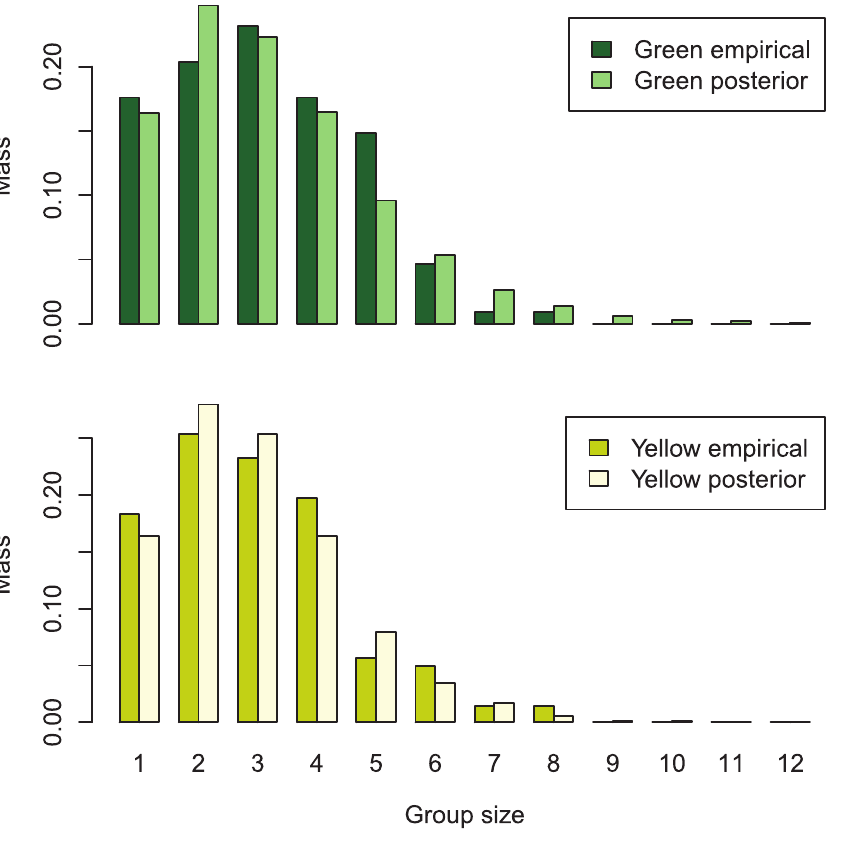
Figure 4. Empirical and posterior predictive distributions of golf tee group size. Bar plots representing the probability mass for group size in the golf tee experiment. Empirical distributions correspond to the actual distribution of group size used in the experiment, while posterior distributions represent estimated posterior predictive distributions obtained after analyzing data with our hierarchical model.